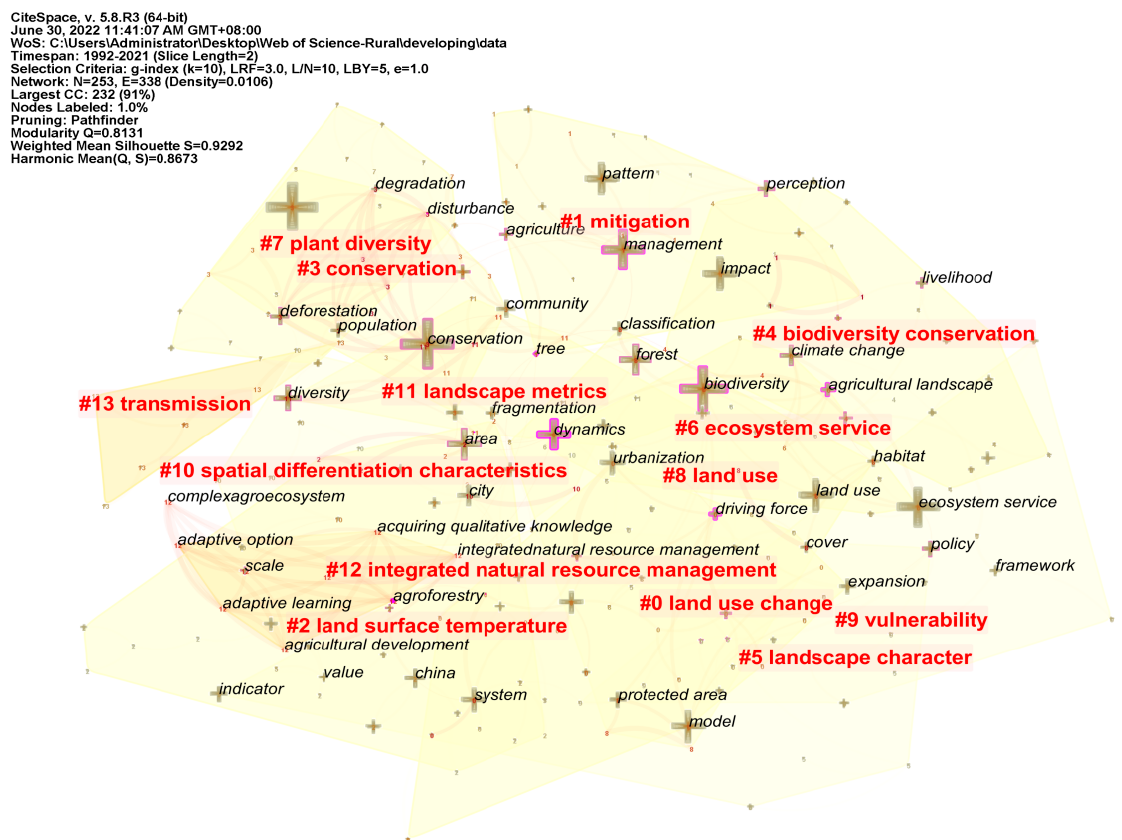
Figure 9. Keyword co-occurrence clustering map in developed countries.